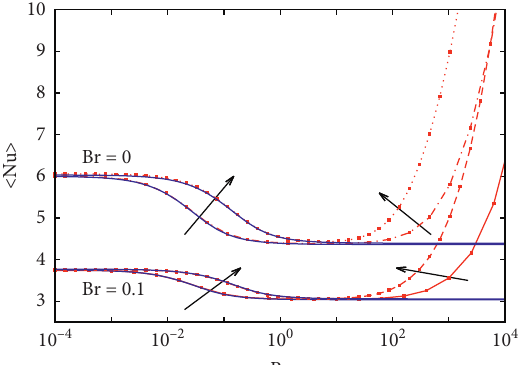
Figure 7: Comparison between numerical (red dotted lines) and analytical results (blue continuous lines) for the average Nusselt 〈 Nu 〉 as a function of Pe for q w ( ζ ) � 1 with Br � 0 and Br � 0 . 1, Kn � 0. Two different values of α are considered, α � 0 . 02 and α � 0 . 1. The arrows indicate increasing values of α